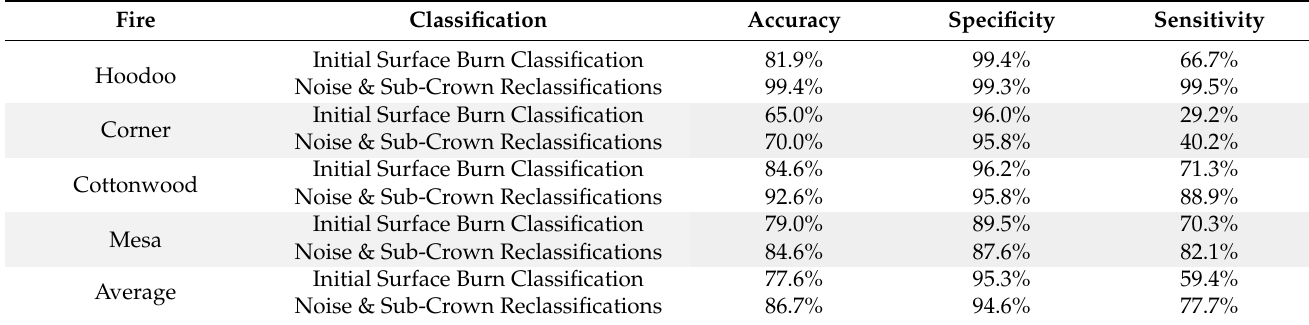
Table 7. Changes in Accuracy, Specificity, and Sensitivity for Each Fire Surveyed.